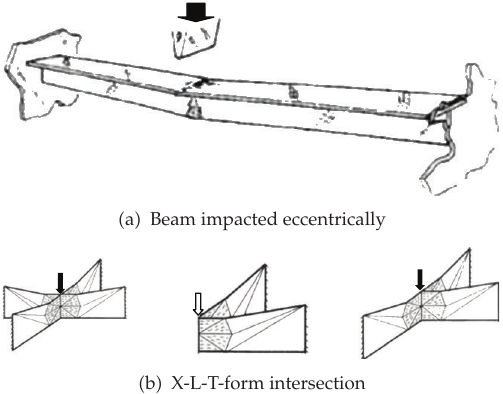
Figure 4: Illustrations for the third and fourth superelements—the figures are extracted from (cid:5) 6 (cid:6)